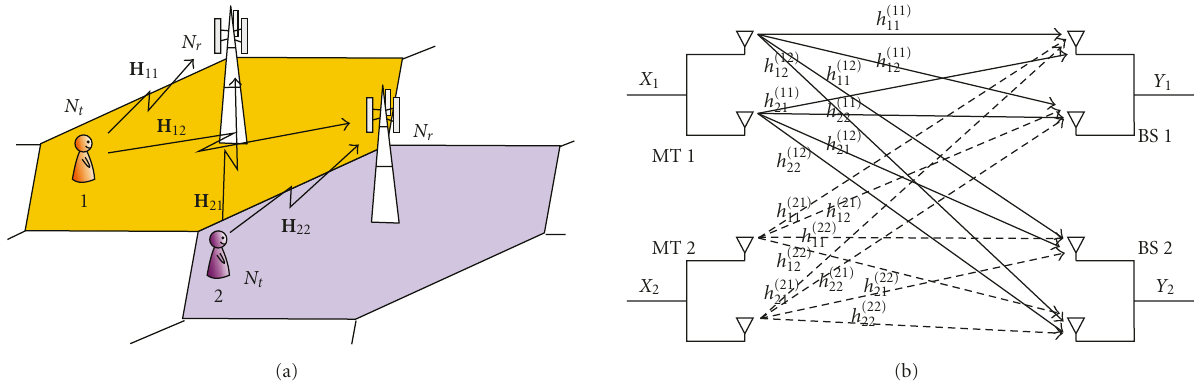
Figure 1: MIMO interference channel: general 2-cell 2-user model (a) and the details representation of the considered 2 × 2 case